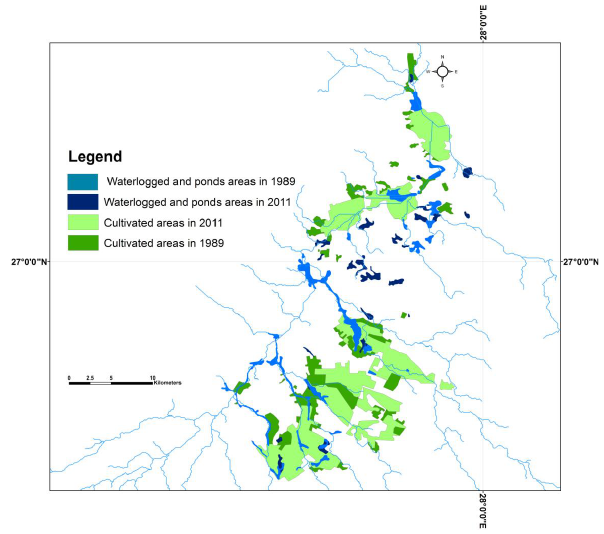
620 Fig 7: The extent of cultivations and waterlogging areas in the Farafra Oasis. 621 Fig. 7. The extent of cultivations and waterlogging areas in the 622 623 Farafra